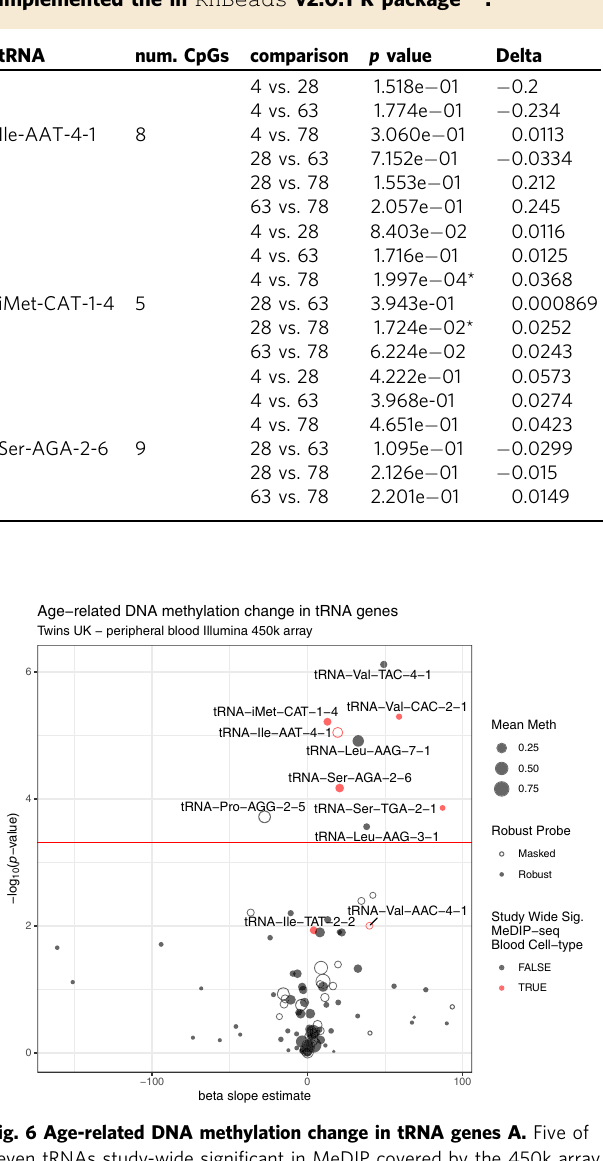
Table 2 Pairwise differences in methylation between age groups by tRNA p values are for pairwise methylation differences using a paired student ’ s t-test and combined by tRNA region using a generalisation of Fisher ’ s method as implemented the in RnBeads v2.0.1 R package 116 .